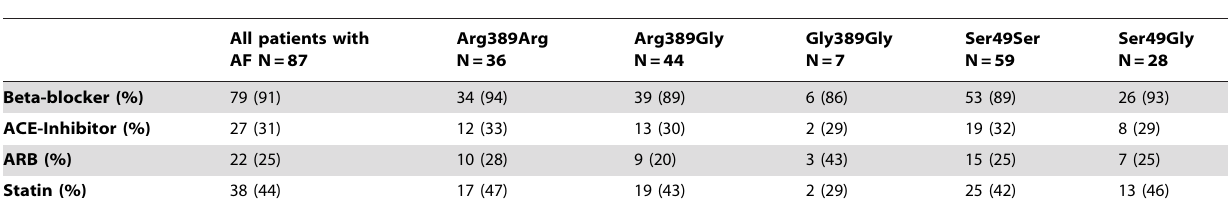
Table 3. Cardiovascular medication in patients with different b 1 AR variants.